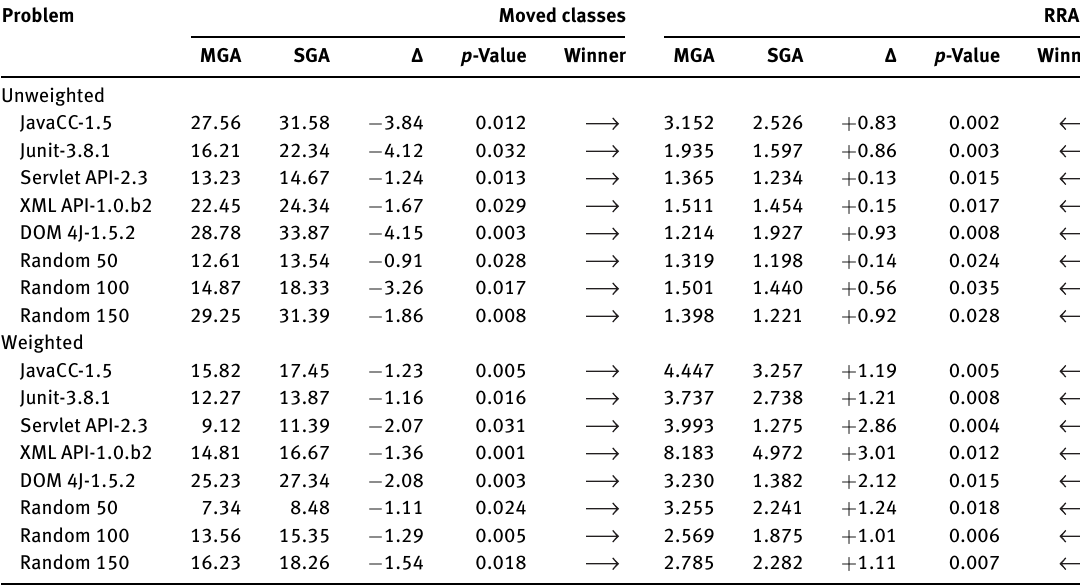
Table 5: Mean Values of Moved Classes and RRAI in Penalized